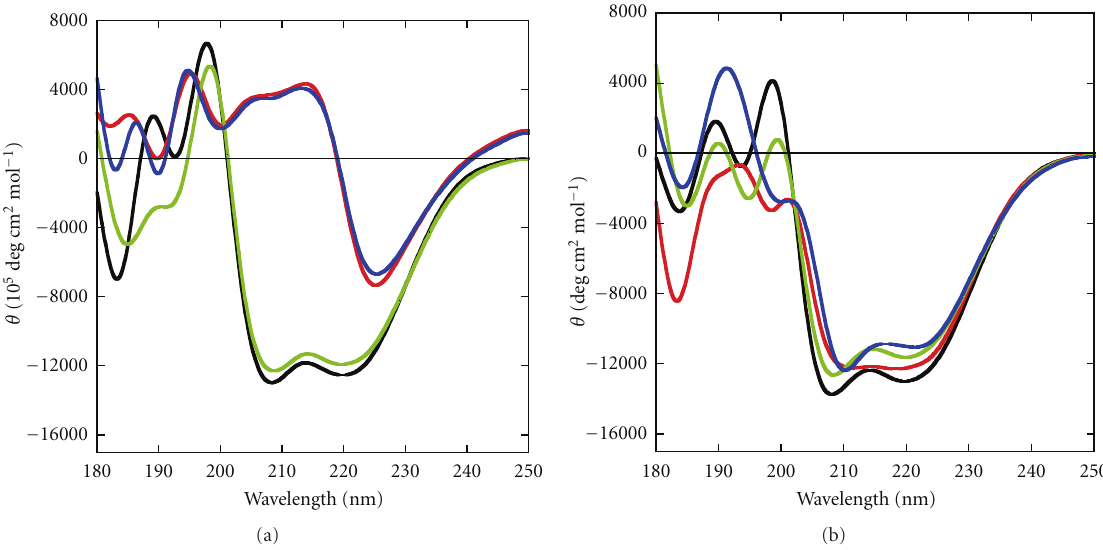
Figure 1: CD spectra of 5 μ M RecG. Measurements were carried out in 30mM MES bu ff er (pH 7.0) containing 100mMNa + and 0.5mMNa 2 EDTA (a) at 0wt% PEG 200 without ATP at 4 ◦ C (black) and 37 ◦ C (green), or with 1 mM ATP at 4 ◦ C (red) and 37 ◦ C (blue), and (b) at 40 wt% PEG 200 without ATP at 4 ◦ C (black) and 37 ◦ C (green), or with 1mM ATP at 4 ◦ C (red) and 37 ◦ C (blue), respectively.